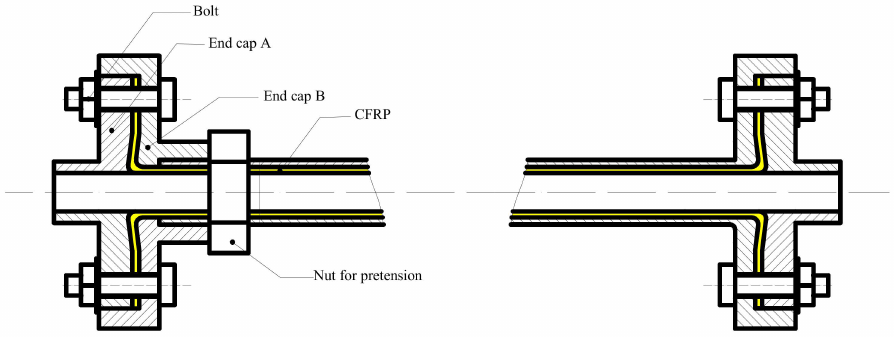
Figure 1. Schematic diagram of improved ball screw.